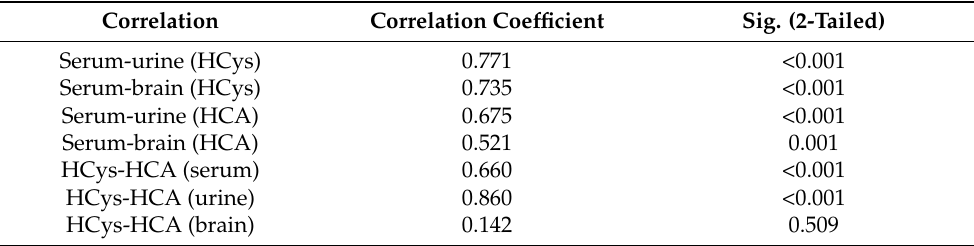
Table 1. Spearman’s rank correlation analysis of hyperhomocysteinemic mice at week 9 (after 8 weeks on deficient